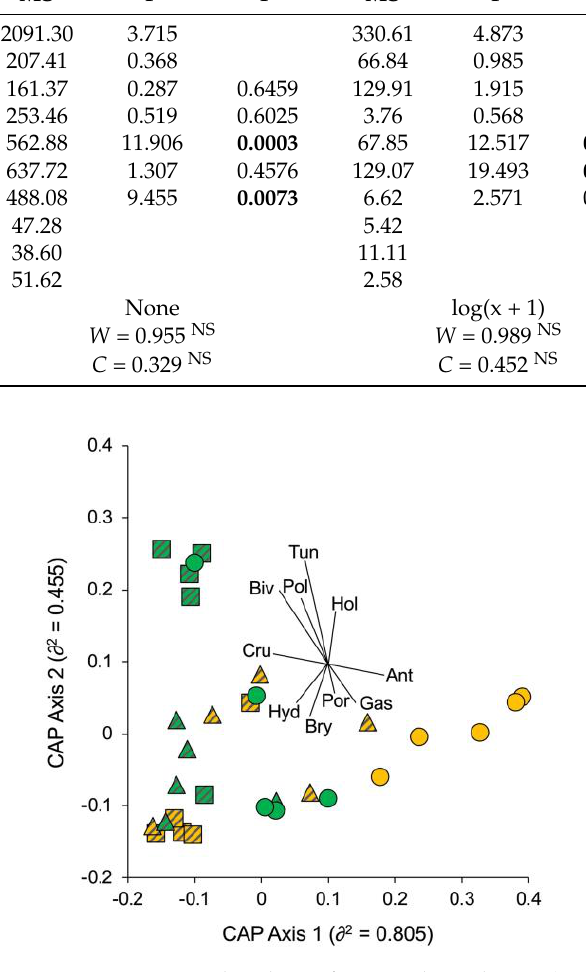
Figure 3. Canonical analysis of principal coordinates (CAP) for the factor Ti × Si based on the distance matrix among sampling units for total biomass of invertebrates at PFN. Squares (dashed) = control site 1 (C1), triangles (dashed) = control site 2 (C2), circles = no-take zone (P). Orange symbols = Time 1 (T1), green symbols = Time 2 (T2). Table 2. Summary of asymmetrical ANOVA testing for differences between P and Cs in total bio- mass (dry weight) of E. amentacea , associated macroalgae, and invertebrates at CIC. The main effect of terms involved in higher-order interactions were not tested. Results of tests for the assumption of normality (Shapiro–Wilk test) and variance heterogeneity (Cochran’s C -test) were also reported: NS = not significant.